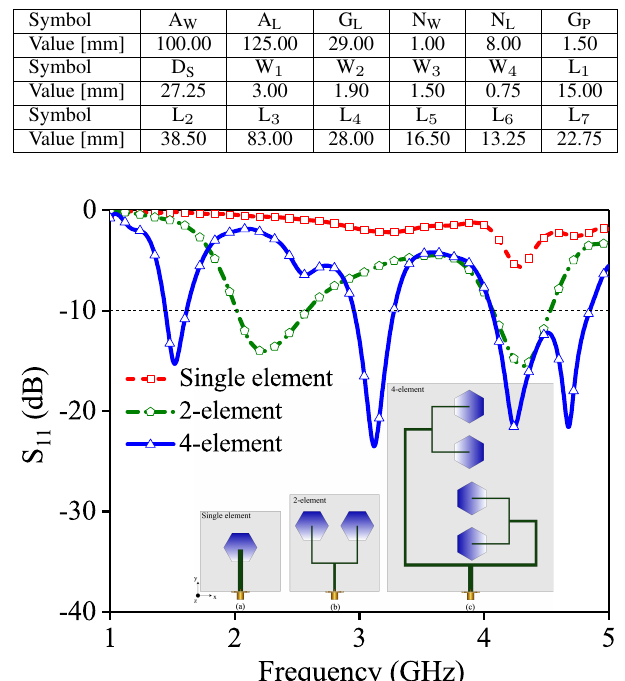
FIGURE 4: Reflection coefficient of single element, 2- element array, and 4-element array.